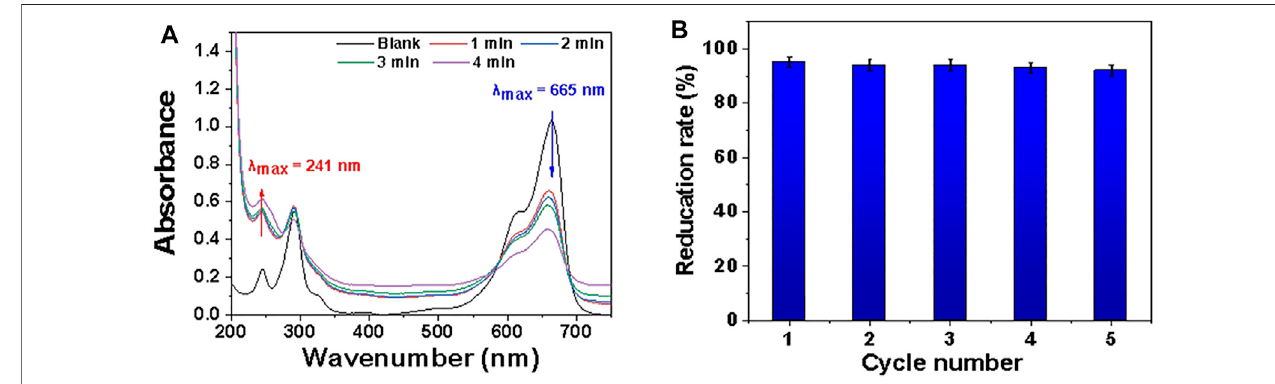
FIGURE 9 | (A) Successive UV-vis absorption spectra UV of MB catalytic reduction process under different time conditions. The blank sample is measured after 40 mg · L − 1 MB solution diluted 10 times. (B) Reduction rate of MB with MDP@PDA fi bers in different cycle